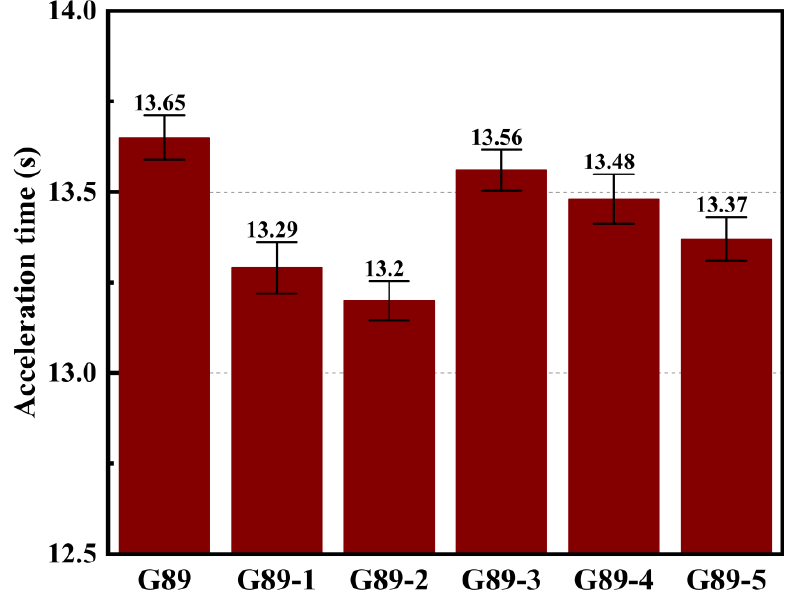
Figure 9. The acceleration time of the PFI vehicle from 0 – 100 km when fueled with the different fuels.